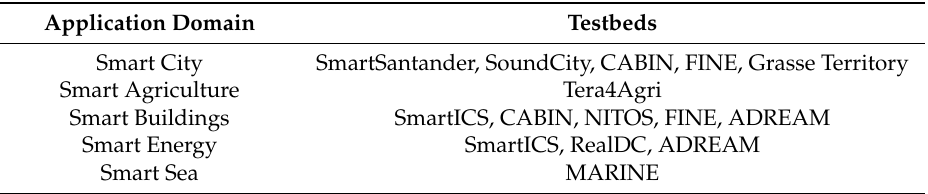
Table 2. Categorization of testbeds in different application